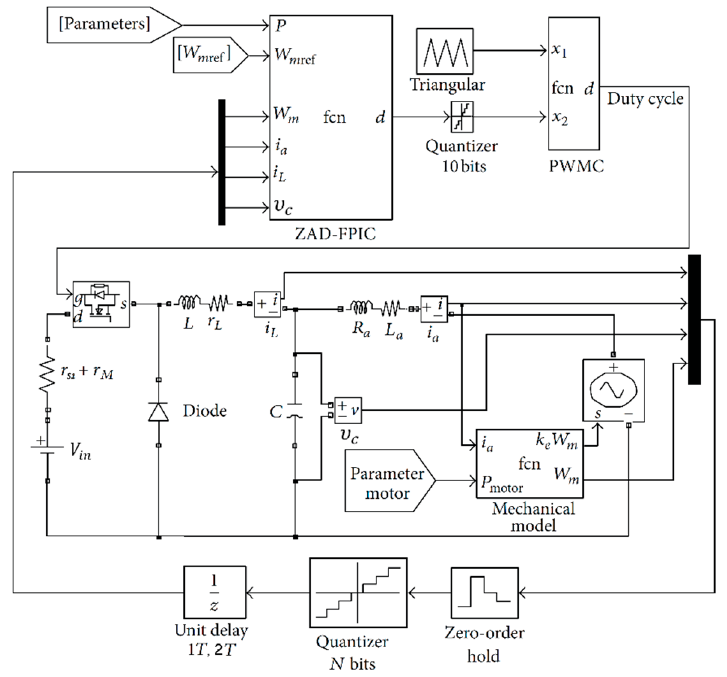
Figure 6. ZAD-FPIC controller simulation blocks.